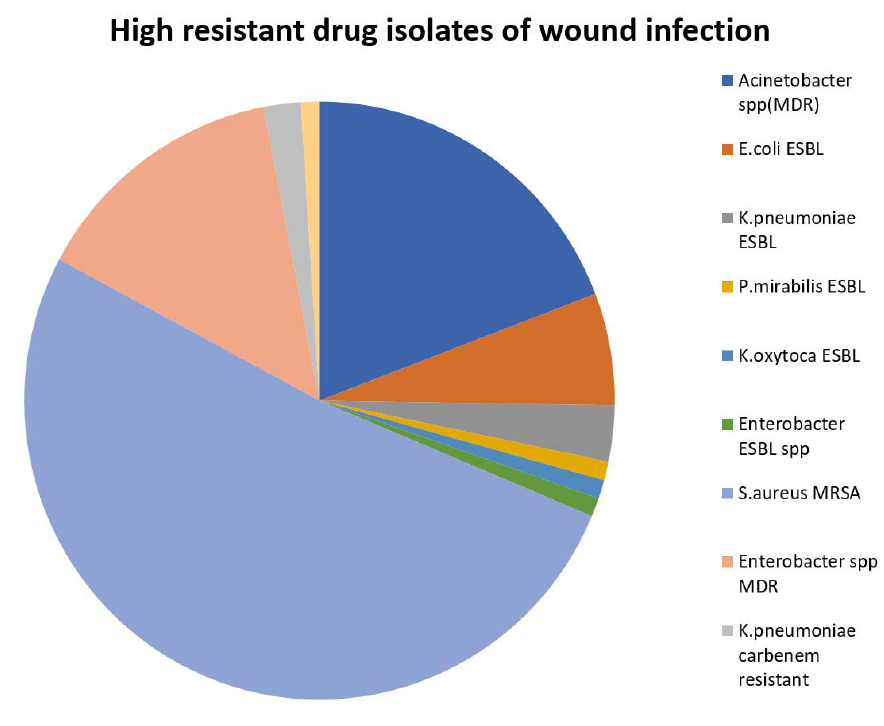
Fig. 5. High drug-resistant isolates of wound infections.